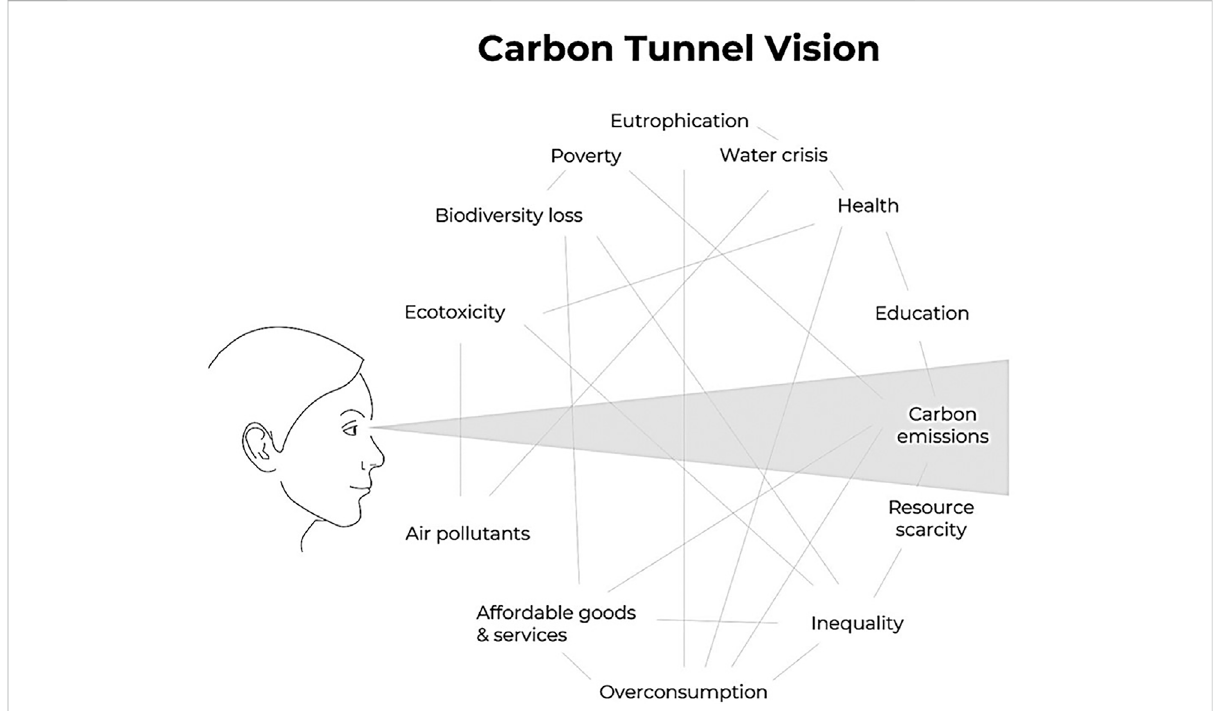
The potential fallback of employing a “ carbon tunnel vision. ” We have to tackle CO 2 emissions, but it must not be our only focus. We need to considersocial responsibility,social impactfactors,andothersustainabilitymetrics.This fi gure wasproducedand adapted withpermissionfromJan Konietzko (Konietzko,